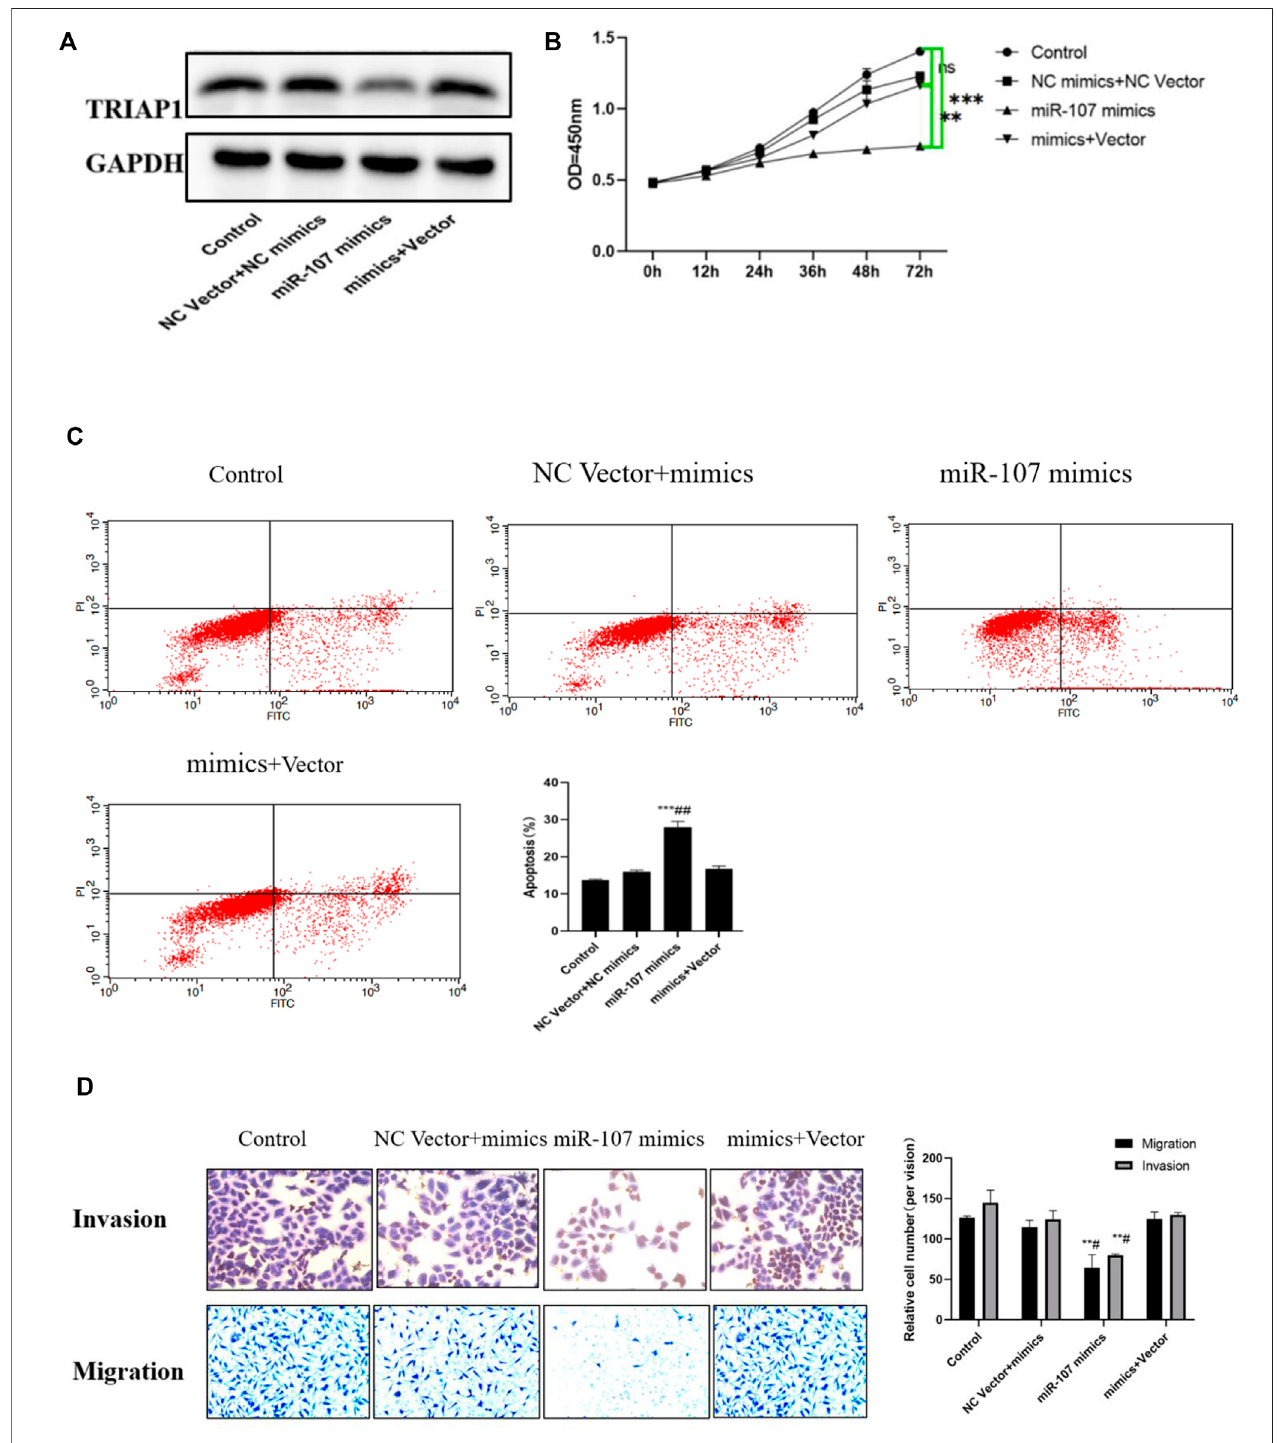
FIGURE 5 | miR-107 mediates NCI-N87 transfer and proliferation through TRIAP1. (A) Western-blotting analysis and quantitation of TRIAP1 after different transfections, (B) Proliferation activity of NCI-N87 cells after different transfection, (C) Invasion and migration of NCI-N87 cells after different transfections, (D) Apoptosis ofNCI-N87cellsafterdifferenttransfection.Comparedwiththecontrolgroup/NCVector+mimicsgroup,* p < 0.05,** p < 0.01,*** p < 0.001,comparedwiththemiR-107 mimics group, # p < 0.05.